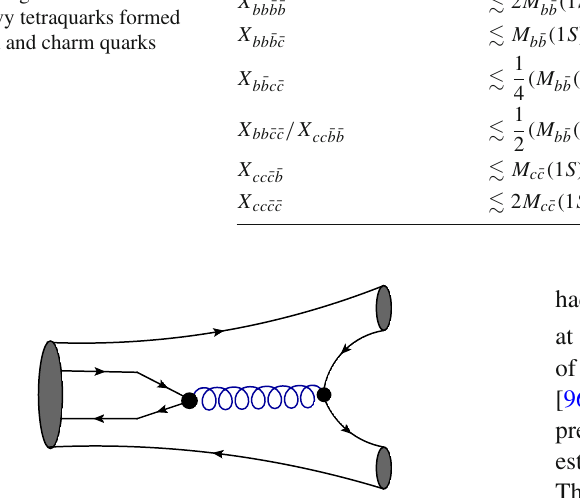
Table 3 Mass inequality relations and upper bounds of the mass of ground-state